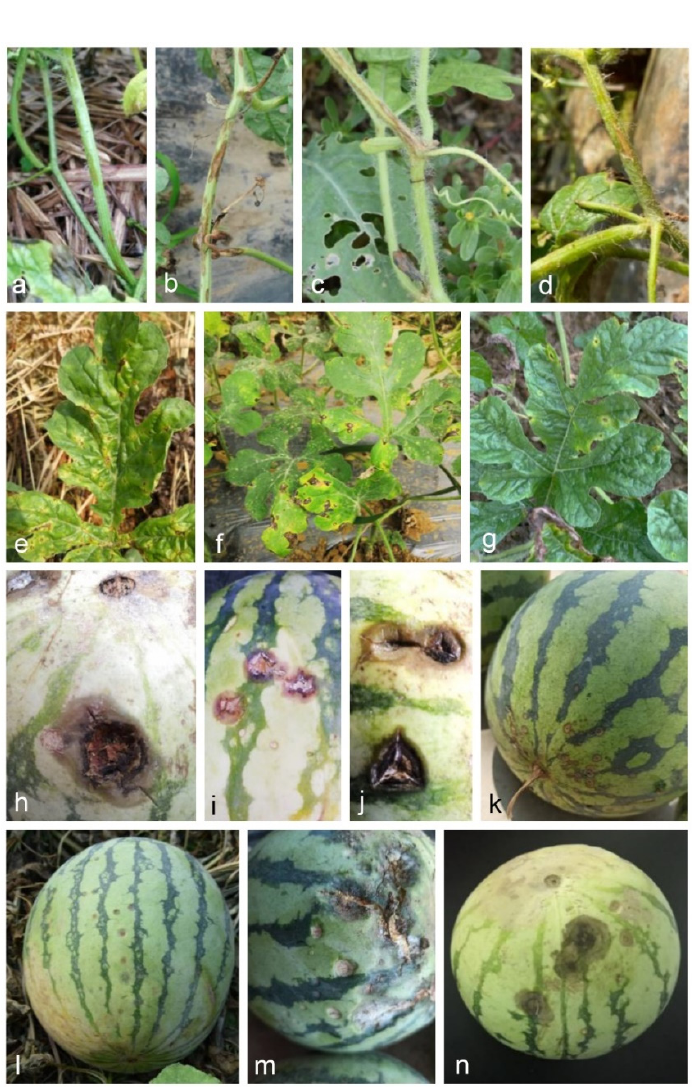
Figure 1. Symptoms of watermelon anthracnose on leaves, stems, and fruits in the field. ( a – d ) Symptoms on leaves of Citrullus lanatus ; ( e – g ) symptoms on stems of Citrullus lanatus ; ( h – n ) symptoms on fruits of Citrullus lanatus .